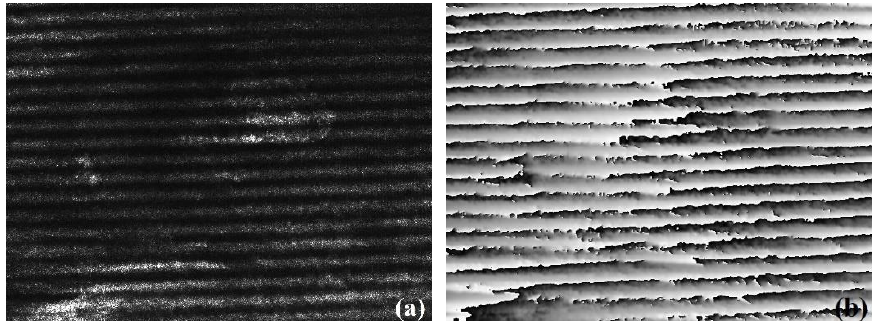
Figure 2. Sinusoidal fringe pattern projected onto the rail surface. (a) Sinusoidal fringe pattern projection on the rail surface. (b) The phase unwrapping result of figure ( a ).